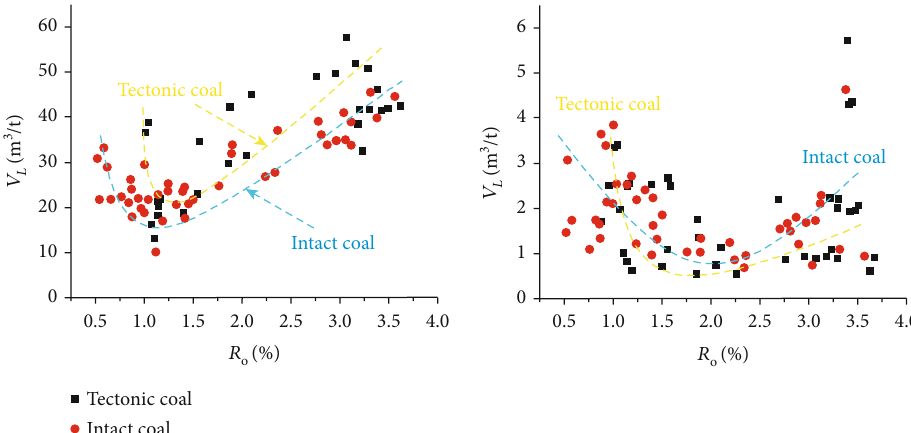
Figure 15: Relationships between the variation of Langmuir parameters with vitrinite re fl ectance of tectonic/intact coals (modi fi ed from Cheng and Pan